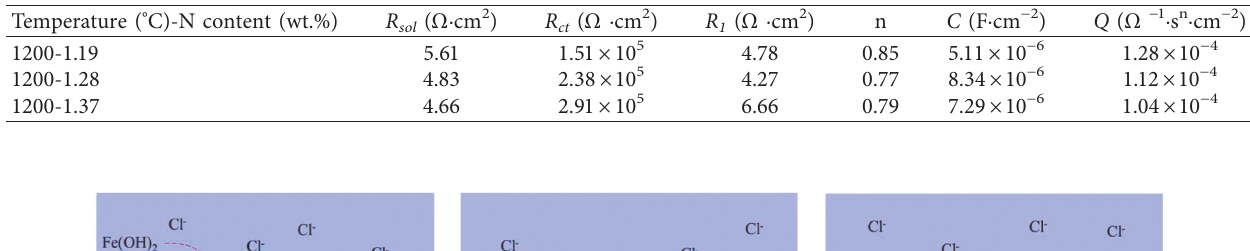
Figure 8: Fitted equivalent circuit. Table 4: EIS equivalent circuit fitting parameters.